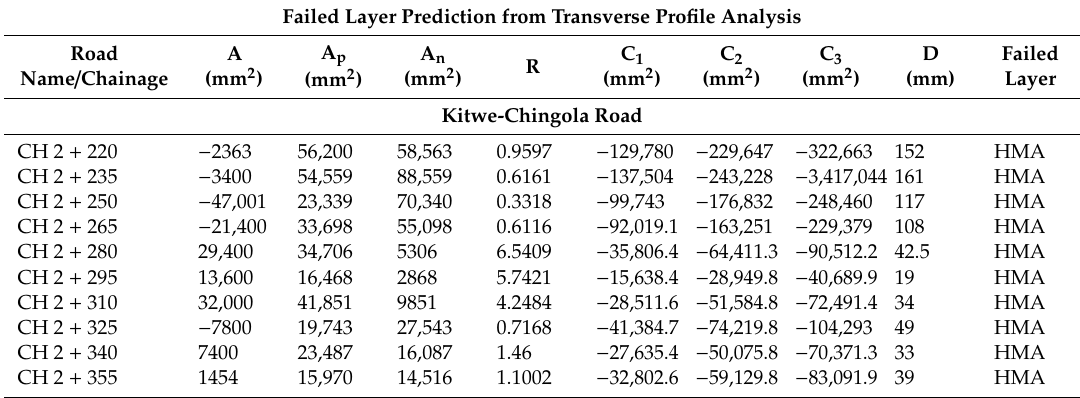
Table 5. Kitwe-Chingola Road profile analysis. Failed Layer Prediction from Transverse Profile